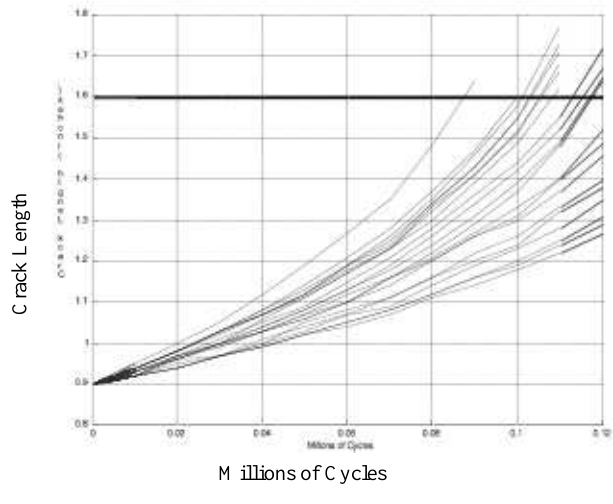
Fig. 7. General Path Model Example